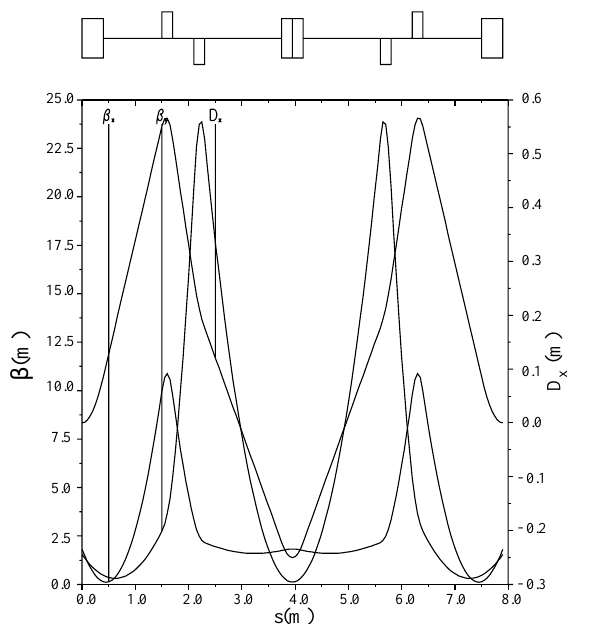
FIG. 5. Optical functions for R 56 (cid:1) 0.04 m.